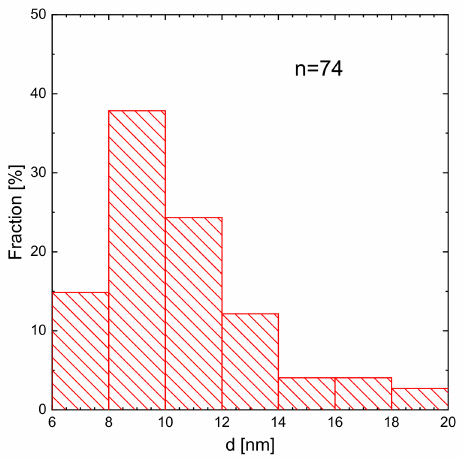
Figure 12. Particle size distribution calculated using HR-TEM